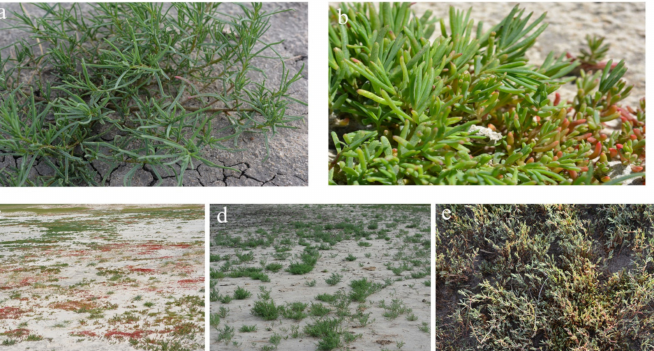
Figure 1. The habitats of S. glauca and S. salsa . ( a ): S. glauca ; ( b ): S. salsa ; ( c – e ): The habitats of S. glauca and S. salsa